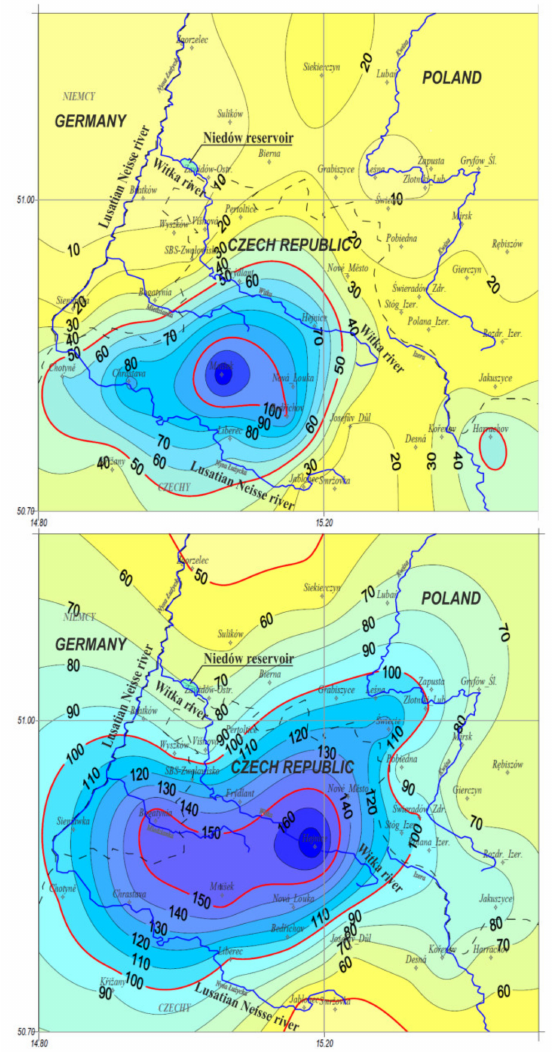
Figure 5. Rainfall values for 6.08.2010 ( top ) and 7.08.2010 ( bottom ) (in mm, source: [33]). The flow of the Witka river—its name on the Czech territory is the Smeda river—is monitored at four gauge stations. On the Polish section from km 0.0 (river mouth) to km 8.0, there are two stations: Ostr ó ˙zno (km 7.98), upstream from the reservoir, and R˛eczyn (km 1.8), downstream from the reservoir (Figure 2). On the 7th of August at the Ostr ó ˙zno gauge station, the highest water level of the flash flood occurred at 16:40. The R˛eczyn gauge station recorded the water level until 15:20 and thus until it was destroyed due to the high release of water from the reservoir before the failure of the dam. During the 45-year period of continuously monitoring flow at Ostr ó ˙zno gauge station, the flood discharges were less than 70 m 3 s − 1 , which is still within the limit of bankful flow. There was only